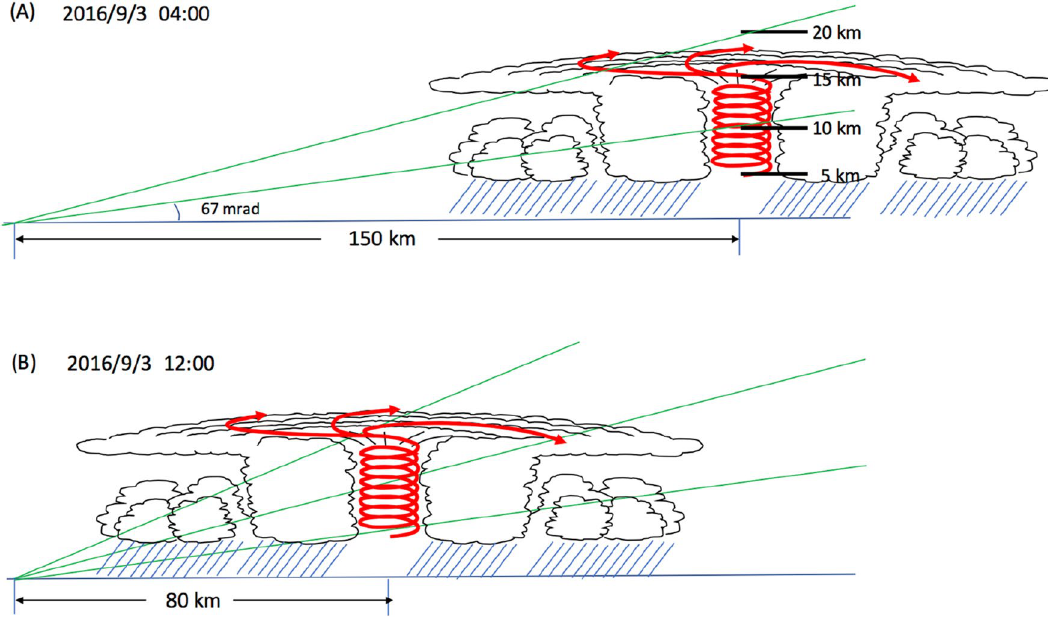
Figure 11. Schematic interpretation of the time-sequential muographic images shown in Fig. 10. The diameter of the storm corresponds to the storm area at 00:00 on September 3. HKMT drew the image with Microsoft PowerPoint software and holds the copyright.